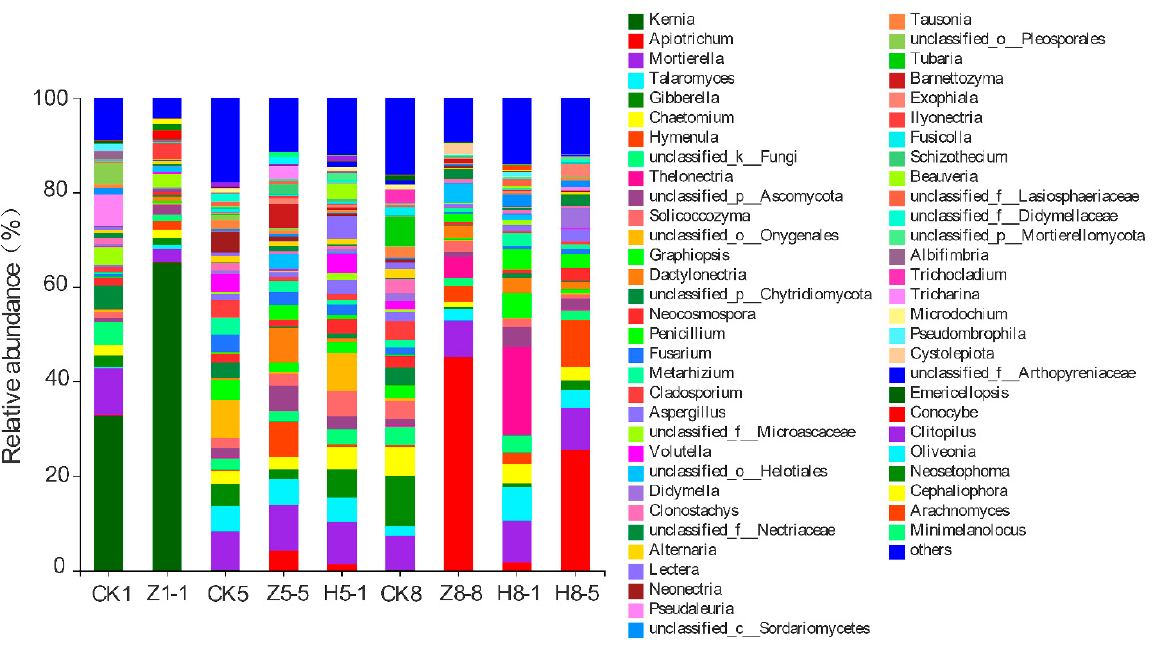
Figure 5. Community composition of fungi at the genus level in soil in different years of growing and replanting. Note: The nomenclature of each sample is the same as that in Table 2.